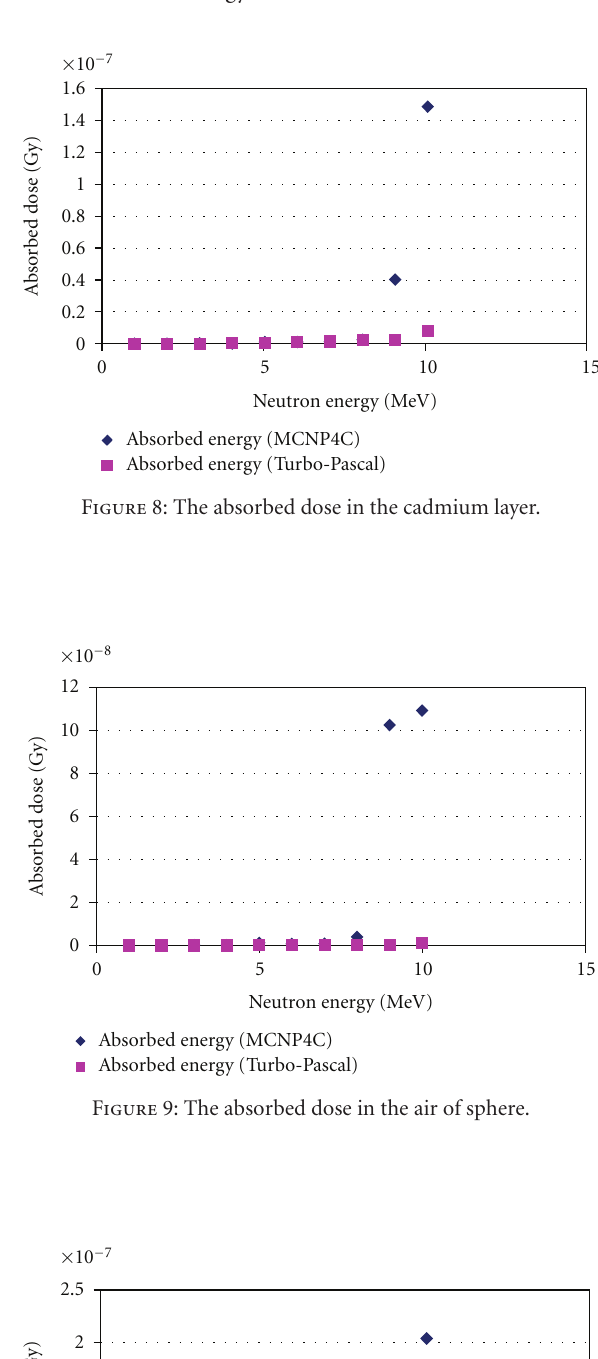
Figure 12: The absorbed doses in the liver tissue and other compo- nents obtained by Turbo-Pascal